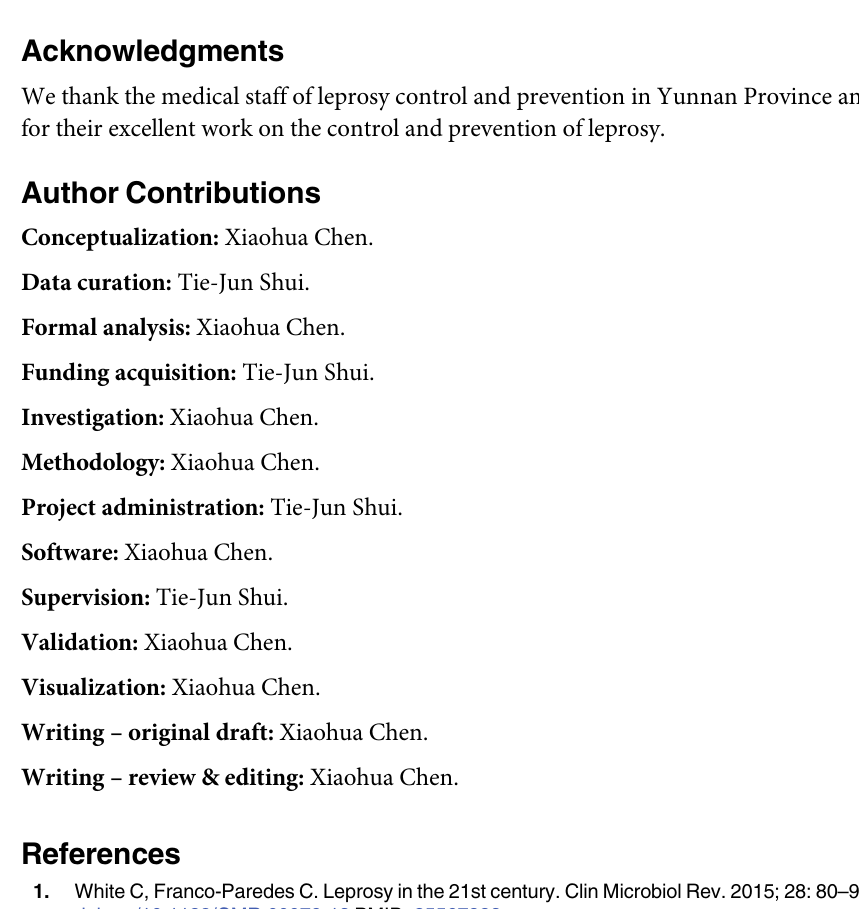
S2 Table. Rates and Proportions of Physical Disabilities Among Newly Detected Leprosy Cases in Yunnan, China, 1990–2020. S3 Table. WHO Leprosy Indicators of Physical Disability Among Newly Detected Leprosy Cases in Yunnan, China,